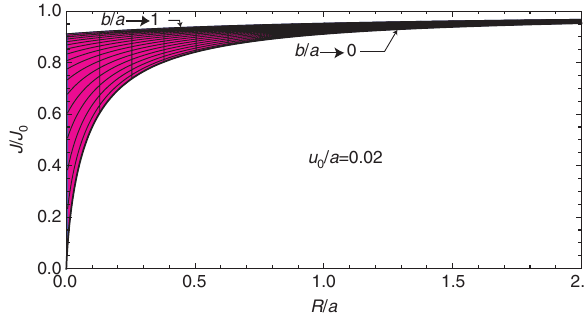
Figure 4: Envelope of normalized J-Integral values versus normalized distance from elliptical boundary at a fixed